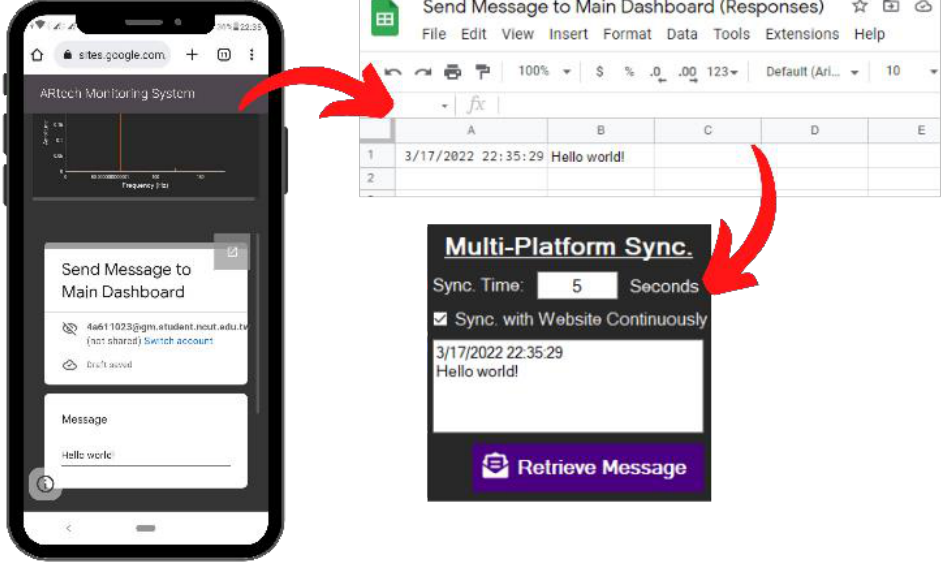
Figure 14. Message-sender feature.